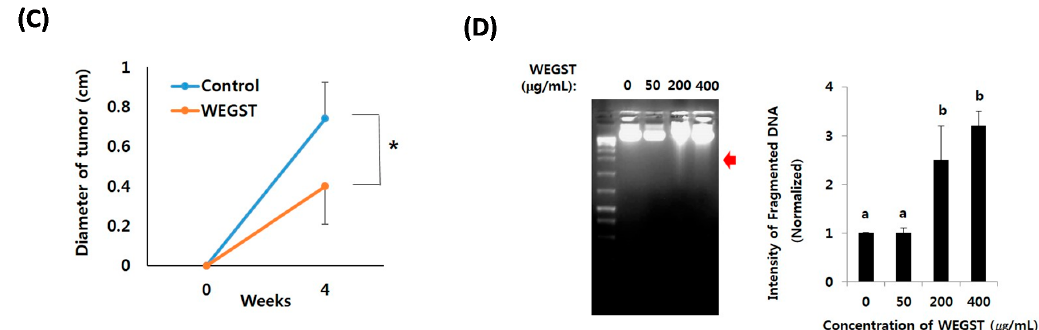
Figure 5. Oral administration of WEGST attenuated tumor formation. PC3 cells were injected subcutaneously. From the day after the inoculation of the PC3 cells, WEGST (25 mg/kg/day) was administered orally to the WEGST mouse group ( n = 7) every day. Four weeks later, all mice were sacrificed, and then the tumors were removed and weighed. Tumors of each group are shown ( A ); and the wet weights ( B ) and sizes ( C ) of seven tumors are illustrated; the weights and sizes of the tumors in the WEGST-administered mouse group were significantly decreased compared with those of the control mouse group. PC3 cells were incubated with various concentrations (0–400 µg/mL) of WEGST, and the fragmented DNA was extracted and resolved in 1.2% agarose gel. Representative figure of three independent experiments are shown ( left panel). The intensities of fragmented DNA areas of three independent experiments were measured using Image J software (Softonic international, SF, USA) and then tabulated ( right panel; normalized by intensity of non-treated cells; 0 µg/mL of WEGST) ( D ). The red arrow indicates fragmented DNA, while the different letters (a, b) in ( D ) indicate significant differences ( p < 0.05) between groups, * p < 0.05 compared with control mouse groups, using the Mann-Whitney U test.